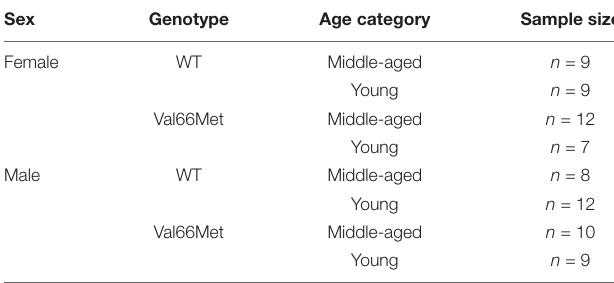
TABLE 1 | Group sizes for all